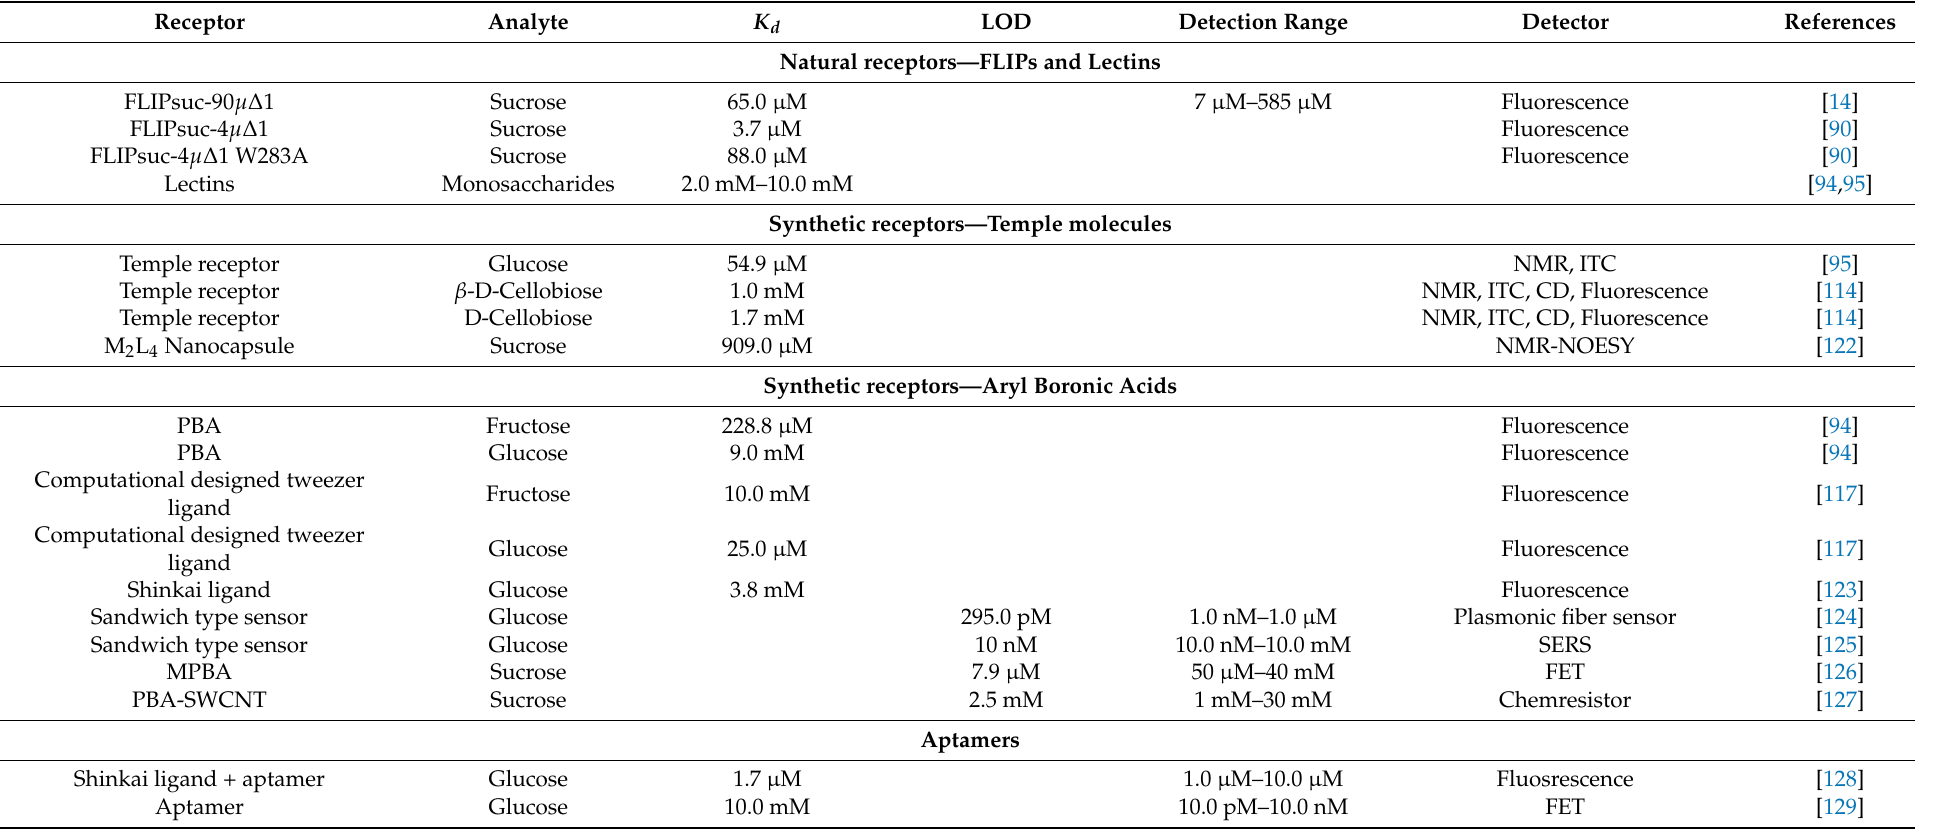
Table 5. Monosaccharides and disaccharides detected with natural or artificial